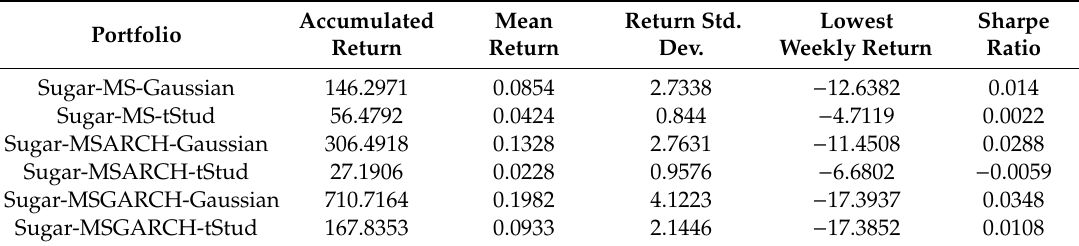
Table 5. Performance summary of the simulated portfolios in the sugar one-month futures’ market (figures in %, with the exception of the Sharpe ratio).